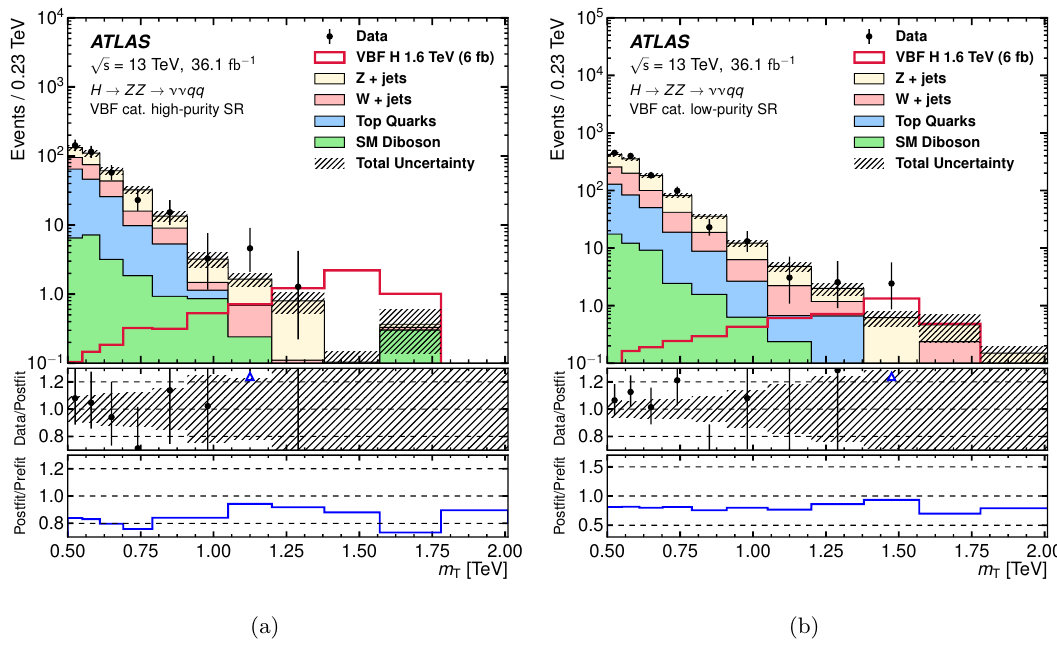
Figure 9 . Comparisons of the observed data and expected background distributions of m T in the VBF category of the H ZZ (cid:23)(cid:23)qq search: (a) high-purity and (b) low-purity signal regions. ! ! For illustration, expected distributions from the VBF production of a 1.6 TeV Higgs boson with (cid:27) ( H ZZ ) = 6 fb are also shown. The middle panes show the ratios of the observed data to (cid:2) B ! the background predictions. The uncertainty in the total background prediction, shown as bands, combines statistical and systematic contributions. The blue triangles in the middle panes indicate bins where the ratio is nonzero and outside the vertical range of the plot. The bottom panes show the ratios of the post-(cid:12)t and pre-(cid:12)t background predictions. and the SM background prediction is in the H ZZ ‘‘qq search, high-purity signal ! ! region, as shown in (cid:12)gure 8(a). A de(cid:12)cit in data is seen around m of 800 GeV, with ‘‘J a local signi(cid:12)cance of 3 : 0 (cid:27) , and by taking into account the look-elsewhere e(cid:11)ect [99]